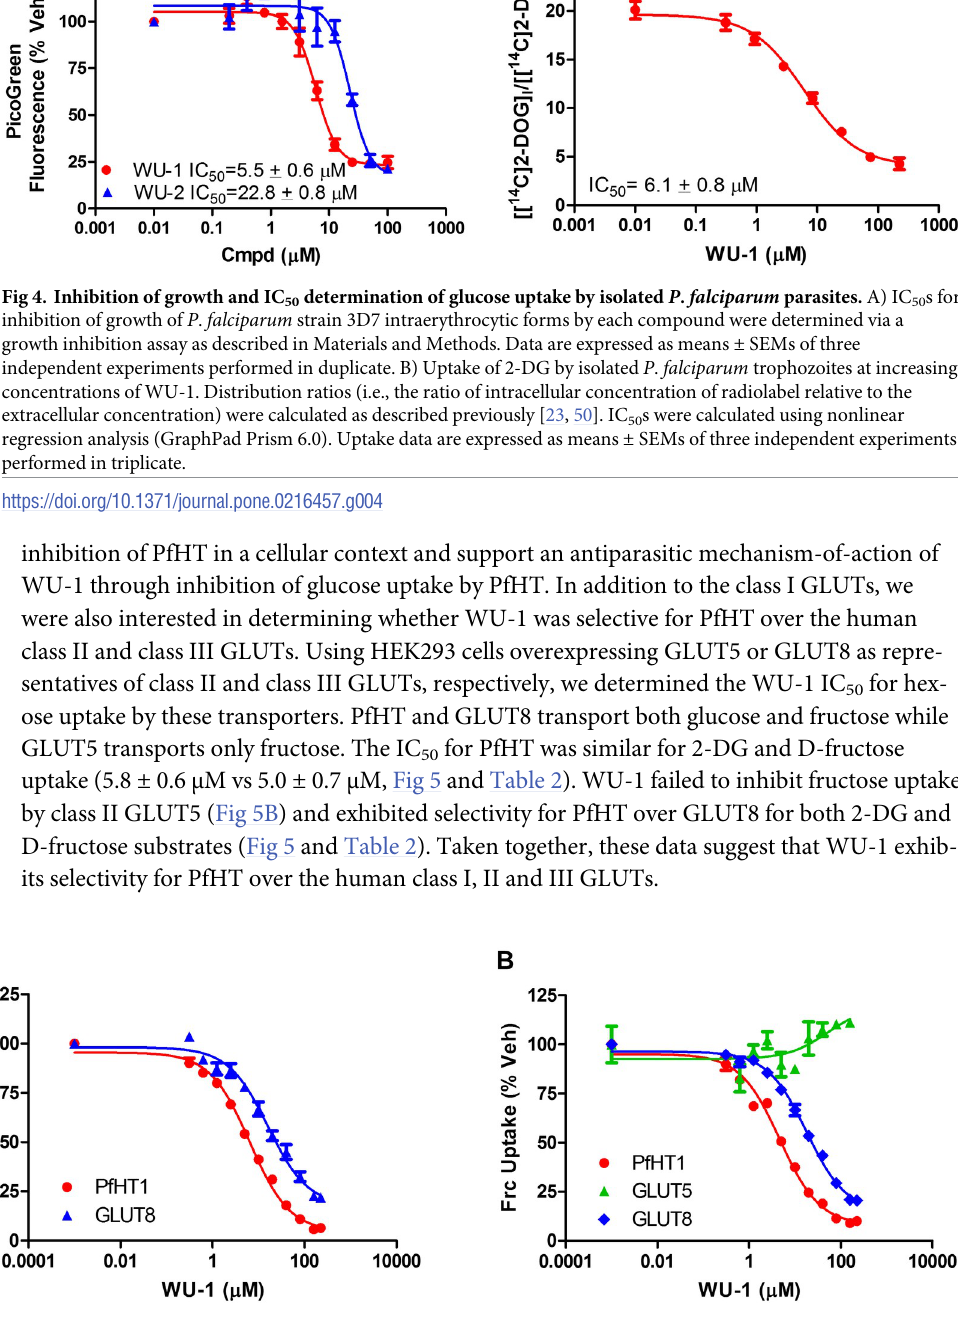
Fig 5. IC 50 determination of hexose uptake by HEK293 cells overexpressing representative human class II and III orthologues. A) Uptake of 2-DG by HEK293 cells overexpressing either PfHT or class III GLUT transporter, hGLUT8. B) Uptake of [ 3 H]-D-fructose (Frc) in HEK293 cells overexpressing hGLUT8, or PfHT or class II transporter, GLUT5. Uptake data are expressed as means ± SEMs of three independent experiments performed in triplicate. IC 50 s were calculated using nonlinear regression analysis (GraphPad Prism 6.0) and are tabulated in Table